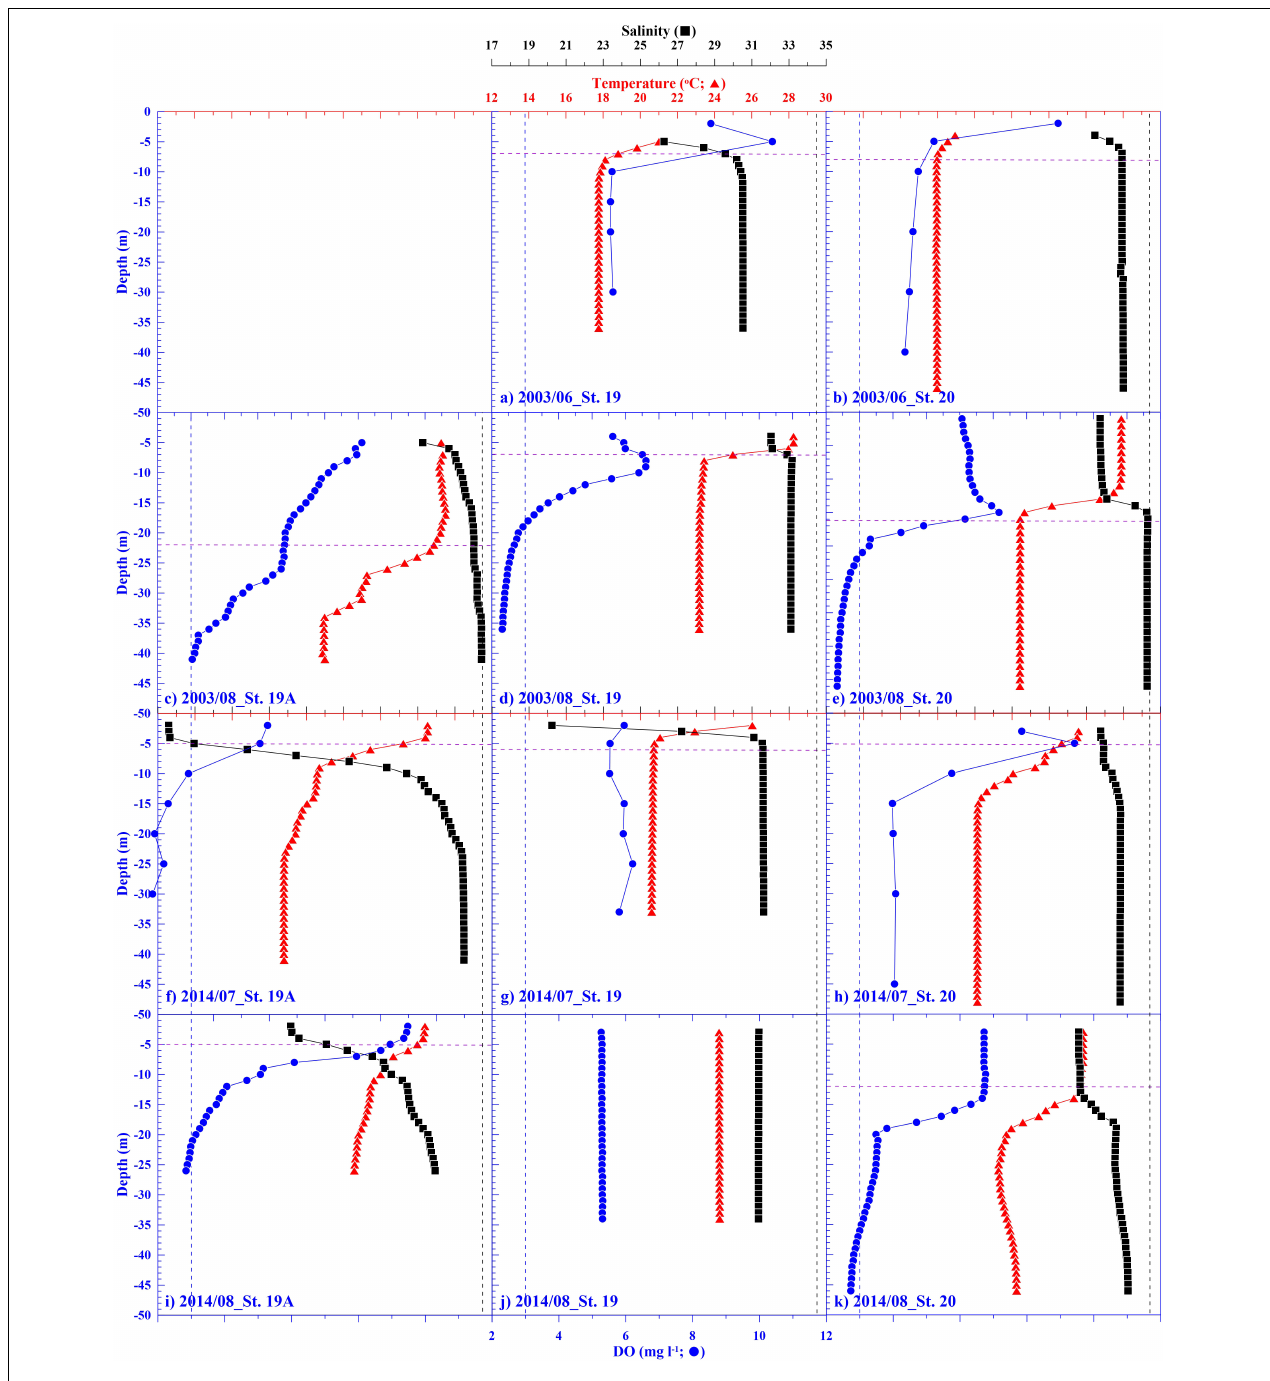
FIGURE 4 | Depth profiles of temperature ( (cid:78) ), salinity ( (cid:4) ), and dissolved oxygen (DO; (cid:108) ) at St. 19A, 19, and 20 in different sampling periods in the East China Sea. Please refer to Figure 1 for stations. For reference, the horizontal dashed lines indicate the mixed layer depth at stations, and the vertical dashed lines indicate where DO = 3 mg L − 1 (blue) and Salinity = 34.26 (black). Please note that panels (a–e) were modified from Chen et al. (2007).